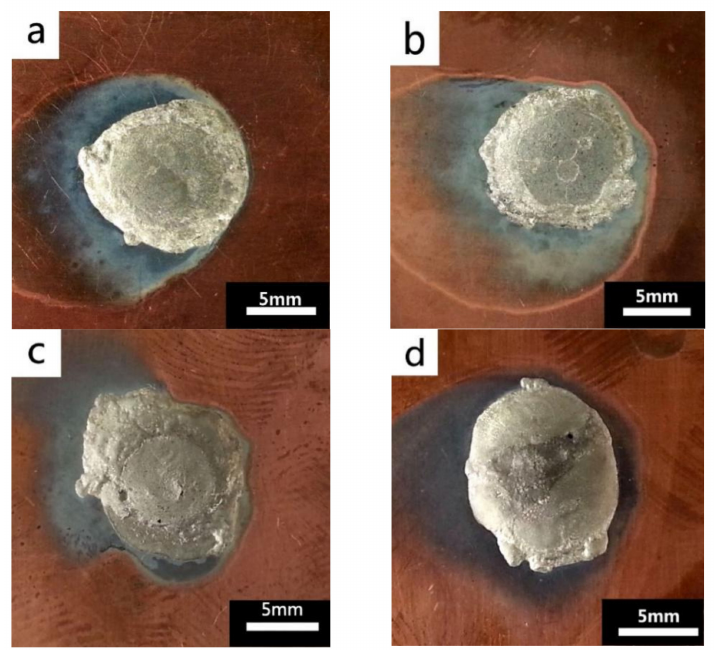
Figure 7. Top-view optical images of Sn-Bi-based solder alloys spreading on substrates: ( a ) Sn-20Bi, ( b ) Sn-20Bi-0.1Al, ( c ) Sn-20Bi-0.3Al, and ( d )